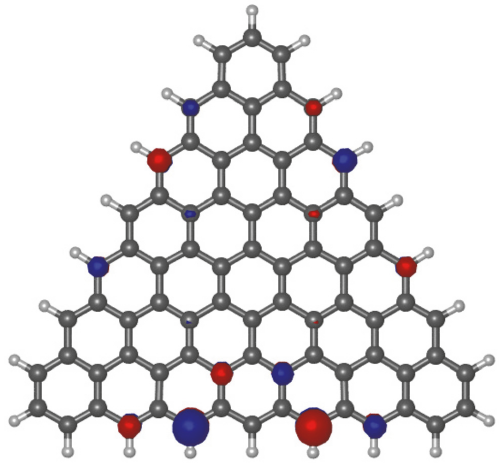
Figure 18: T 7 magnetic orbital 2.